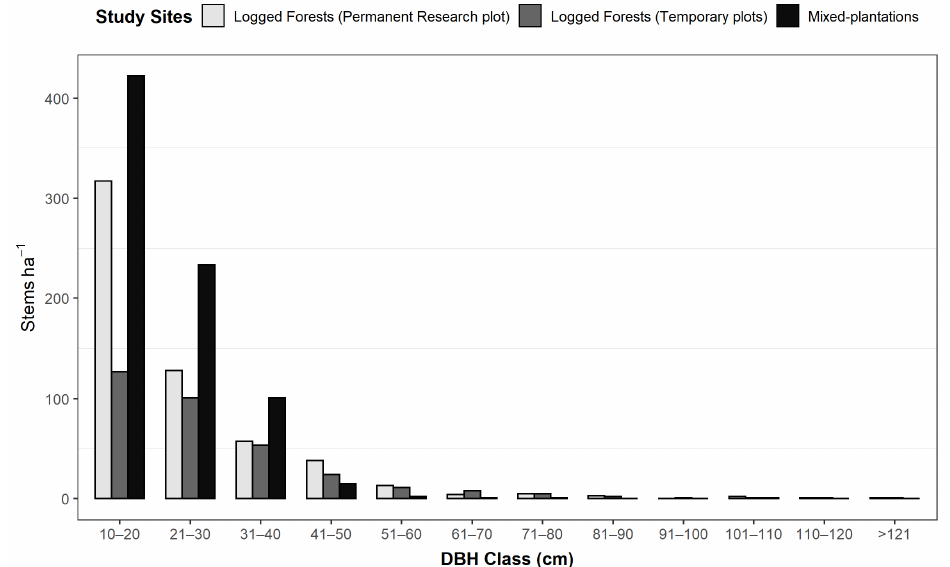
Figure 2. Diameter classes found in the three study sites.